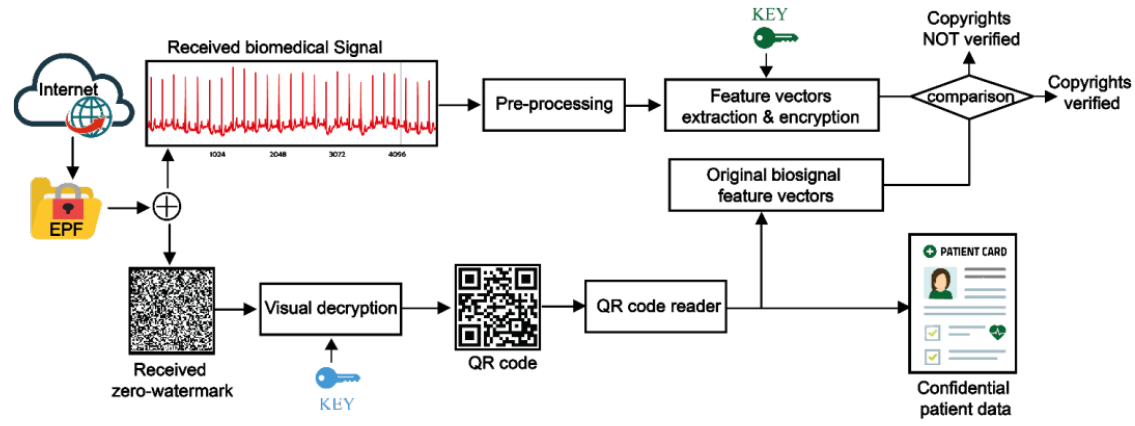
Figure 9. The proposed patient data recovery and bio-signal copyright verification.